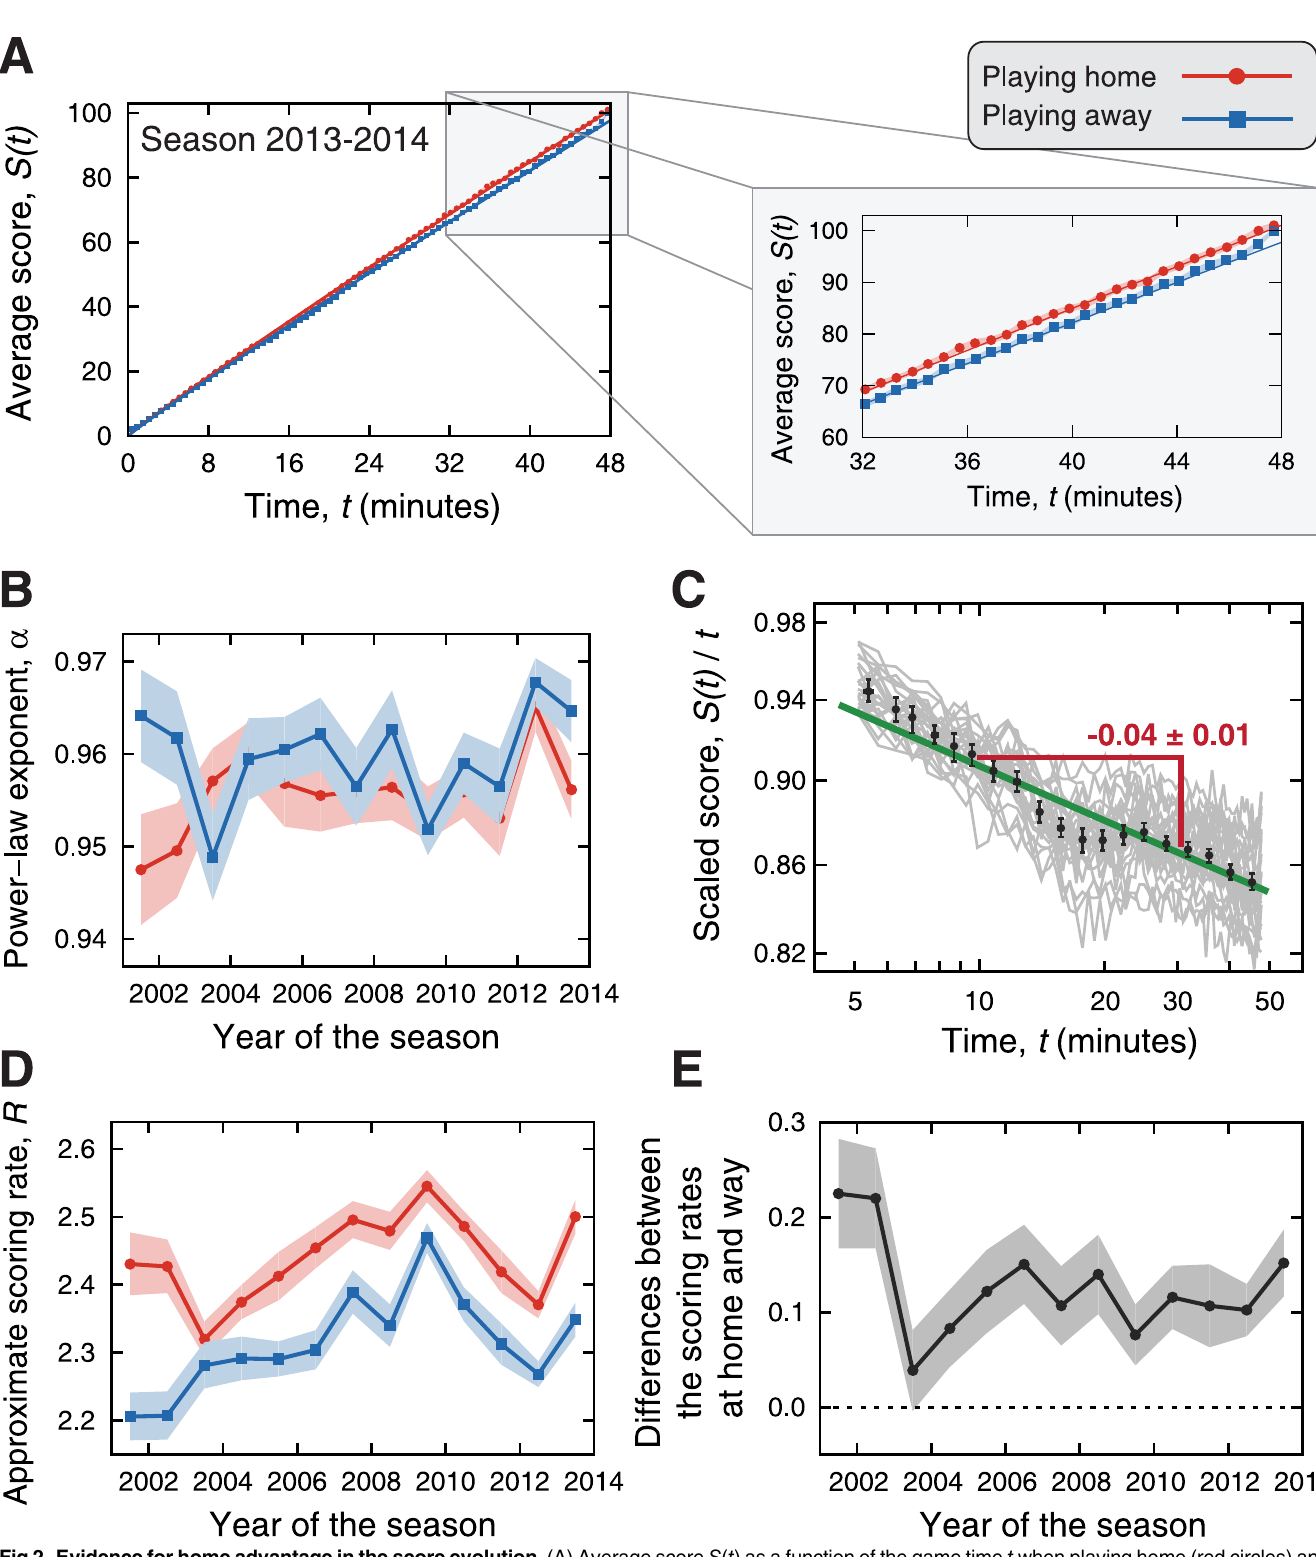
Fig 2. Evidence for home advantage in the score evolution. (A) Average score S ( t ) as a function of the game time t when playing home (red circles) and away (blue squares). These averages were calculated for the NBA season 2013 – 14 (see S1 Fig for all seasons). The last 16 minutes of the games are highlighted. The continuous lines (red for home and blue for away) represent the adjusted power-law models [ S ( t ) = Rt α ]. Notice that the difference between